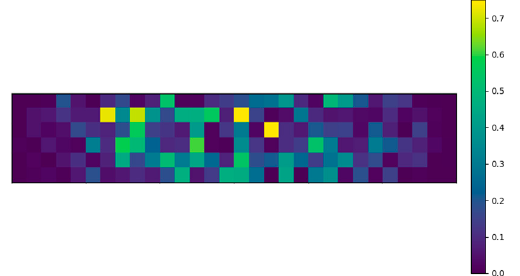
Figure 6. Stress intensity factor for bottom surface (with a flaw density of 1 flaw/cm 2 for visualization).